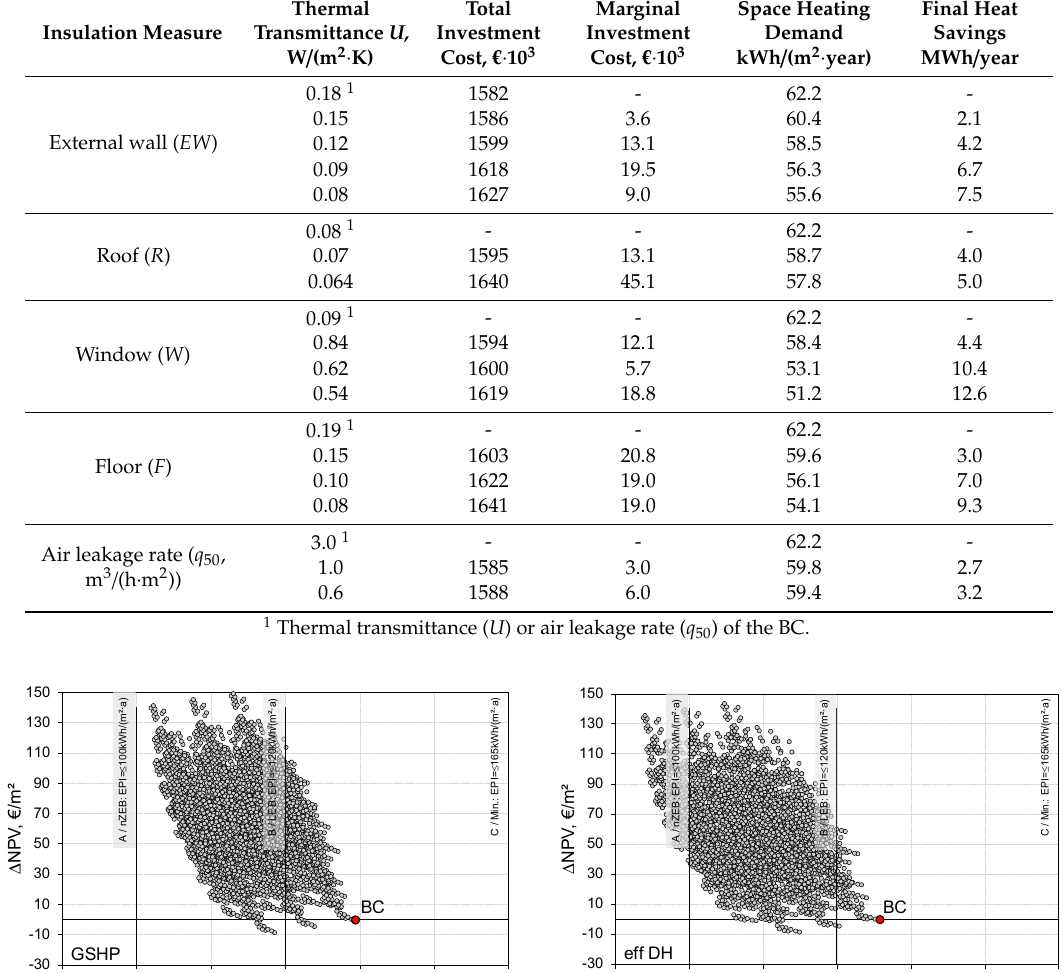
Table6. Thermaltransmittance, investmentcosts, spaceheatingdemand(deliveredenergy), andsavings for various insulation measures (VAT 0%).